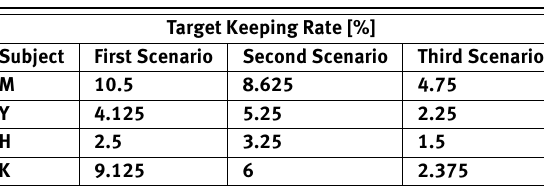
Table 6. The target keeping time and target keeping rate of the task